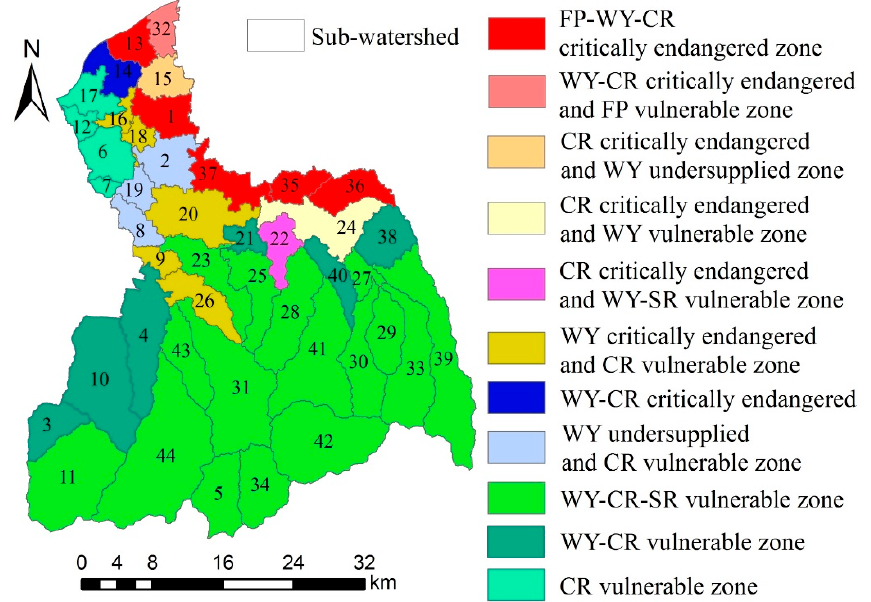
Figure 15. Space management zoning of the FRW.